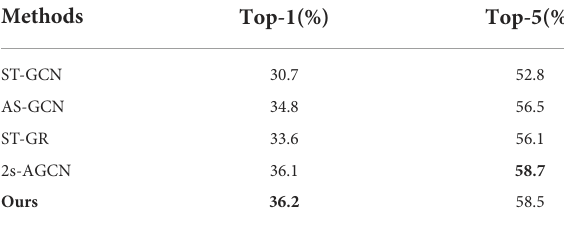
TABLE 3 Comparison of different algorithms on Kinetics Skeleton 400 dataset.